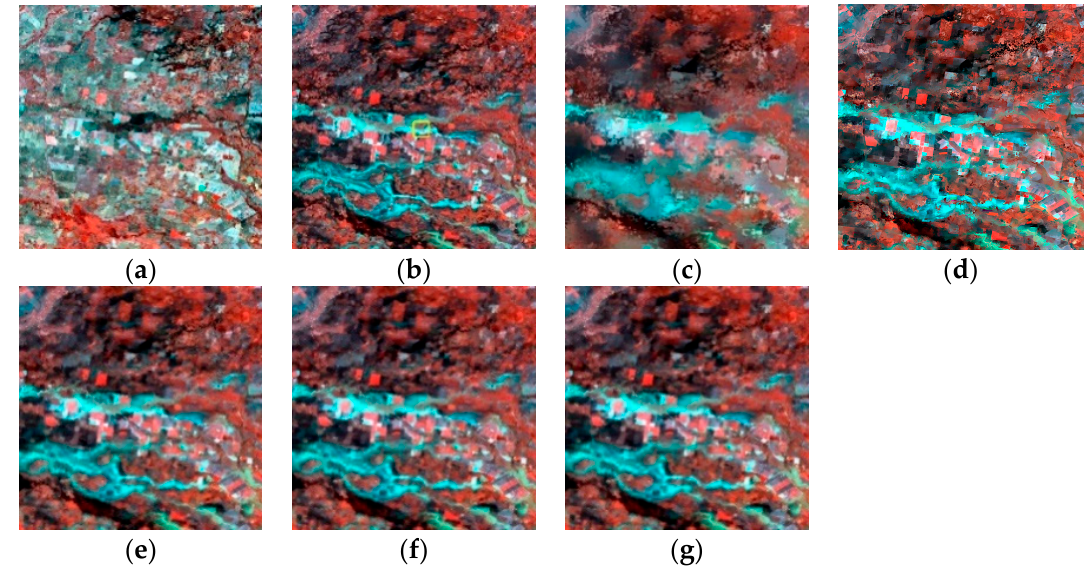
Figure 7. Original Landsat images on November 26, 2004 ( a ), and December 12, 2004 ( b ), and the images predicted by UBDF( c ), FIT-FC( d ), FSDAF( e ), SFSDAF( f ), and adaptive-SFSDAF( g ).